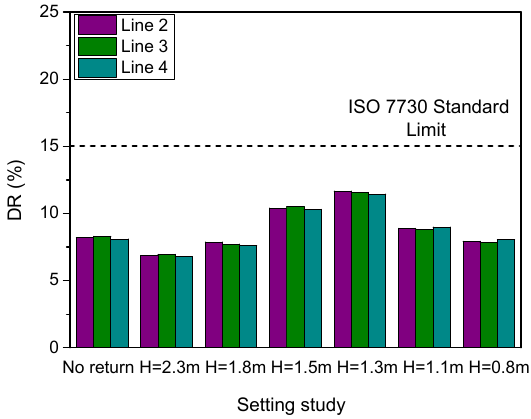
Figure 9. Draught rate (DR) index for different settings.